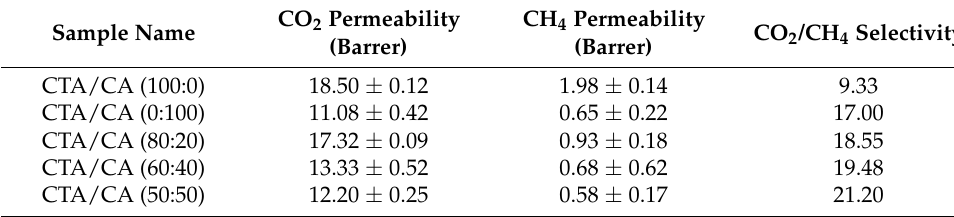
Table 3. Gas separation performance of fabricated membranes.